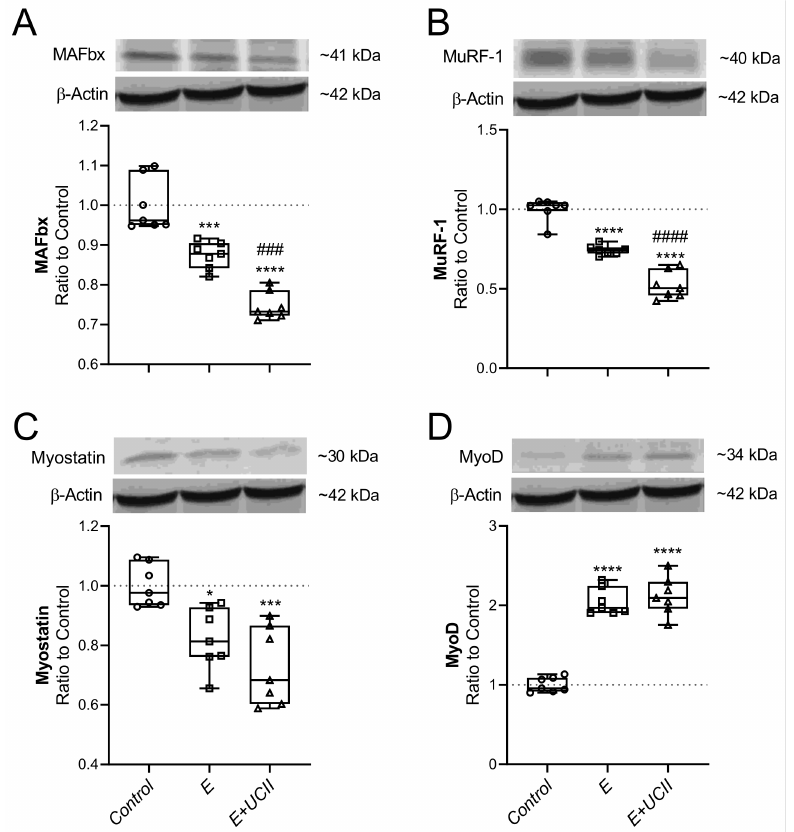
Figure 5. The effect of UCII on the muscle MAFbx ( A ), MuRF-1 ( B ), Myostatin ( C ), and MyoD ( D ) levels in exercised rats. The densitometric analysis of the relative intensity according to the control group of the western blot bands (Figure S2) was performed with β -actin normalization to ensure equal protein loading. Blots were repeated at least three times ( n = 3), and a representative blot is shown. Box and Whisker plots show median, min, and max values. Data are expressed as a ratio of the control set at 1.0. ANOVA and Tukey’s post-hoc test were used to compare the results among different treatment groups. Statistical significance between groups is shown by: * p <